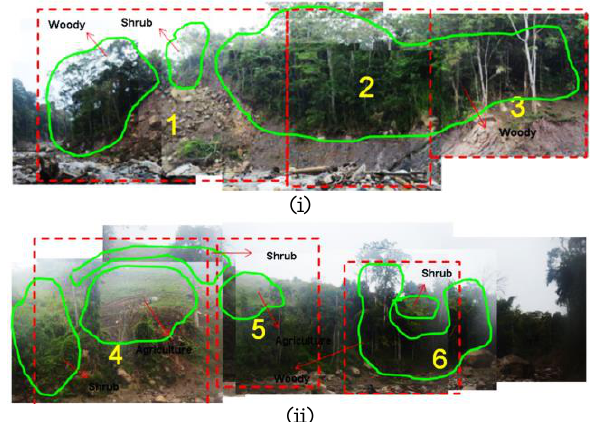
Figure 13. Landslide profiling on 6 landslide polygons (green color) and its delineation based on different type of